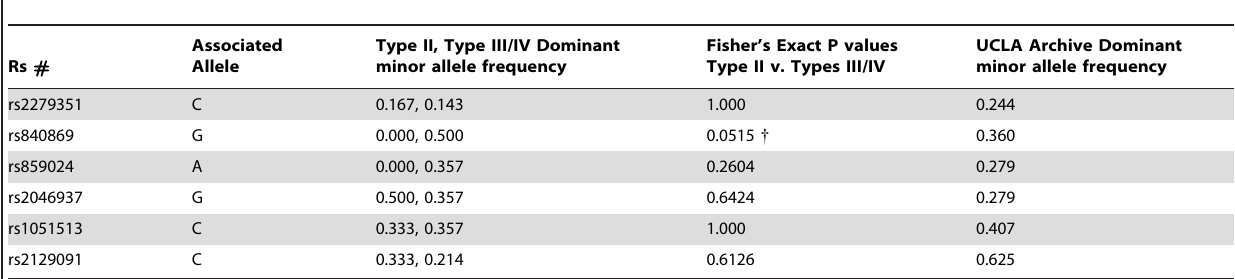
Table 3. FGFR1OP2/wit3.0 SNP minor allele distribution in edentulous subjects (n= 20) and UCLA archival DNA (n=86) *.